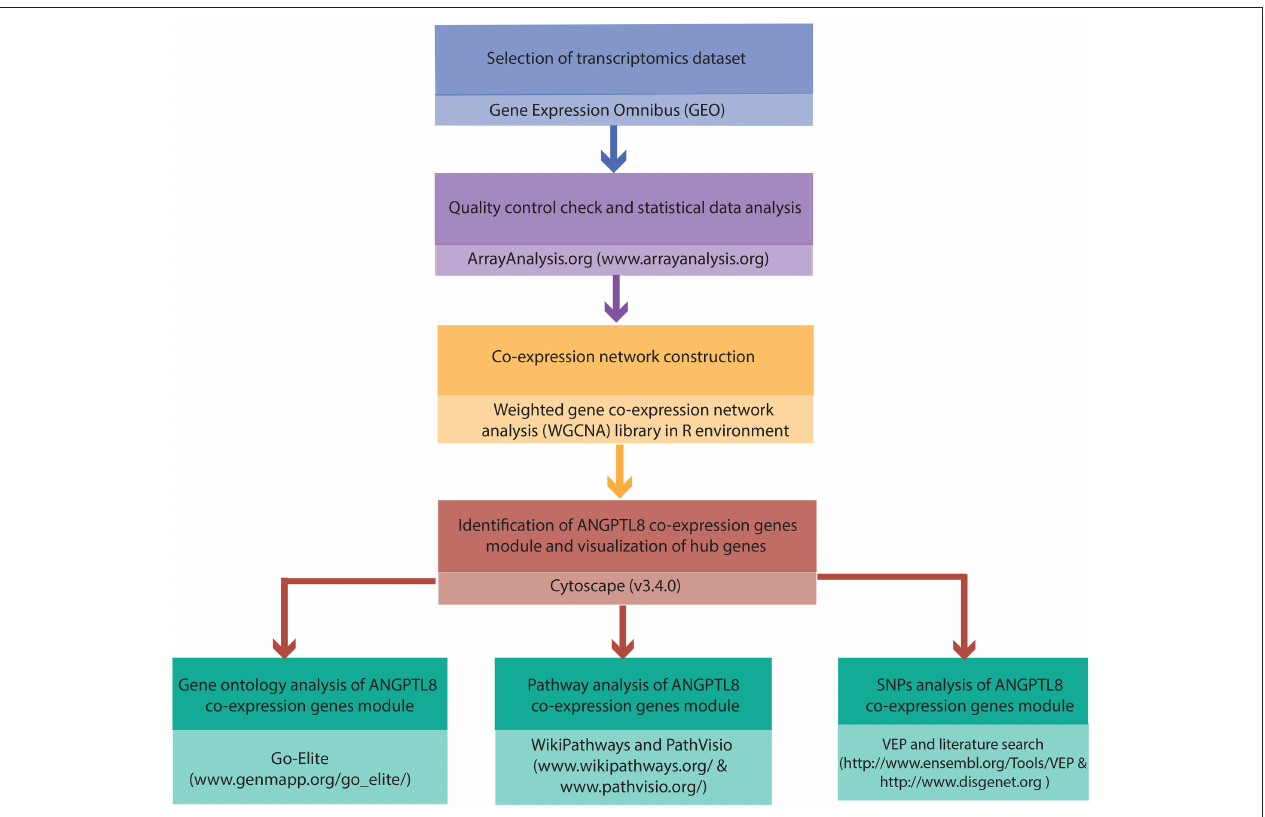
FIGURE 1 | Integrated workflow deployed for functional assessment of ANGPTL8: The steps and the tools/softwares used for the the quality control assessment, construction of ANGPTL8 co-expression network, Gene Ontology analysis, pathway analysis and variant effect prediction analysis (through SNPs identification) are